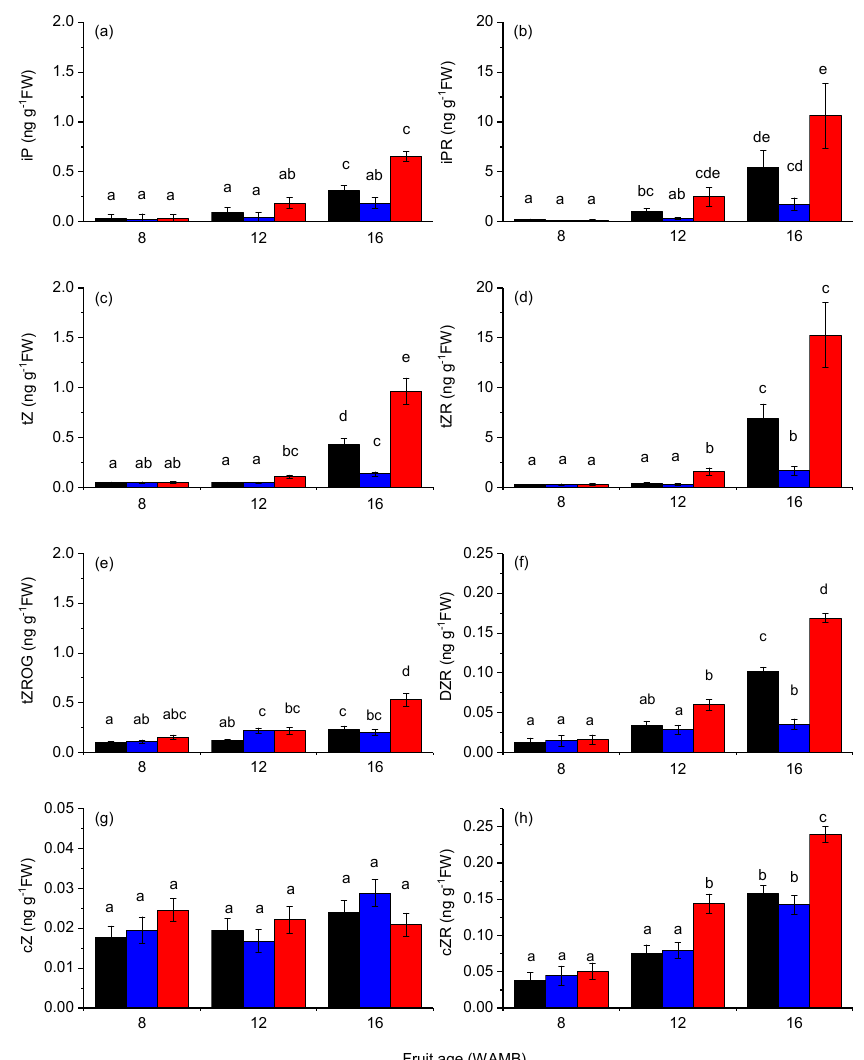
Figure 2. Cytokinin concentrations in the outer pericarp of developing kiwifruit: ( a ) iP, isopentenyl adenine; ( b ) iPR, isopentenyl adenine riboside; ( c ) tZ, trans -zeatin; ( d ) tZR, trans -zeatin riboside; ( e ) tZROG, trans -zeatin- O -glucoside; ( f ) DZR, dihydrozeatin riboside; ( g ) cZ, cis -zeatin; ( h ) cZR, cis -zeatin riboside.. Untreated control (black bar; vine standard), low carbohydrate supply (blue bar), and high carbohydrate supply (red bar). Values are averages ± SEM ( n = 3 or 4). Statistical analysis by linear mixed effects model with type 3 sums of squares Kenward–Roger’s method; different letters mean a statistical difference adjusted for multiple comparison by Tukey’s correction ( p < 0.05). Fruit age is in weeks after mid bloom (WAMB). FW, fresh weight.